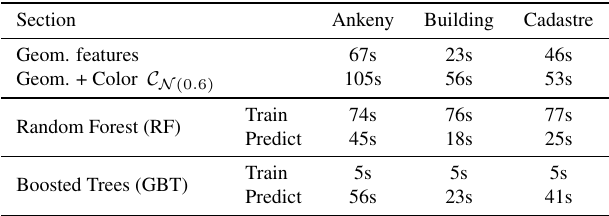
Table 4. Timings for feature computation, classifier training and prediction. Our whole pipeline runs in less than 3 minutes